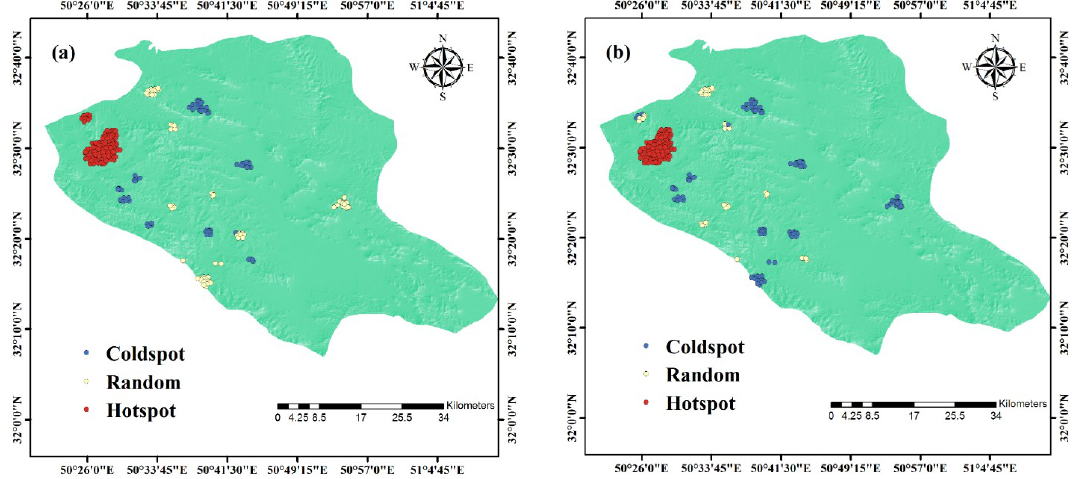
Figure 9. Forest fire hotspot analysis of ( a ) the forest fire years and ( b ) the FRP.